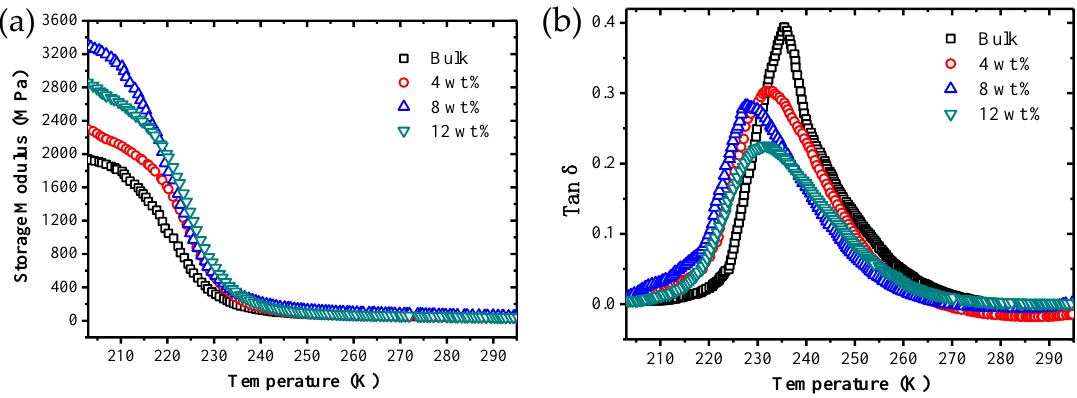
Figure 5. The storage modulus ( a ) and loss tangent ( b ) versus temperature curves of SMPC specimens with different carbon fiber content.